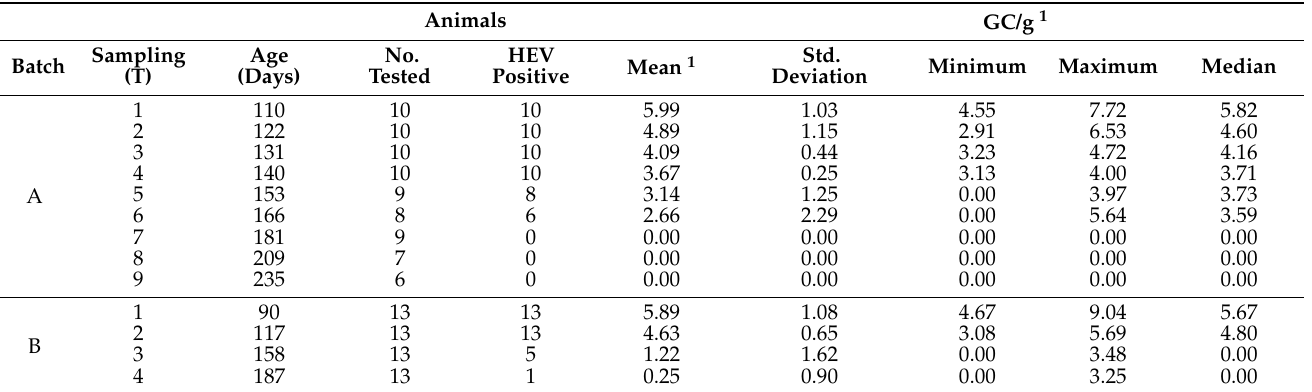
1 Values indicated are expressed as the log